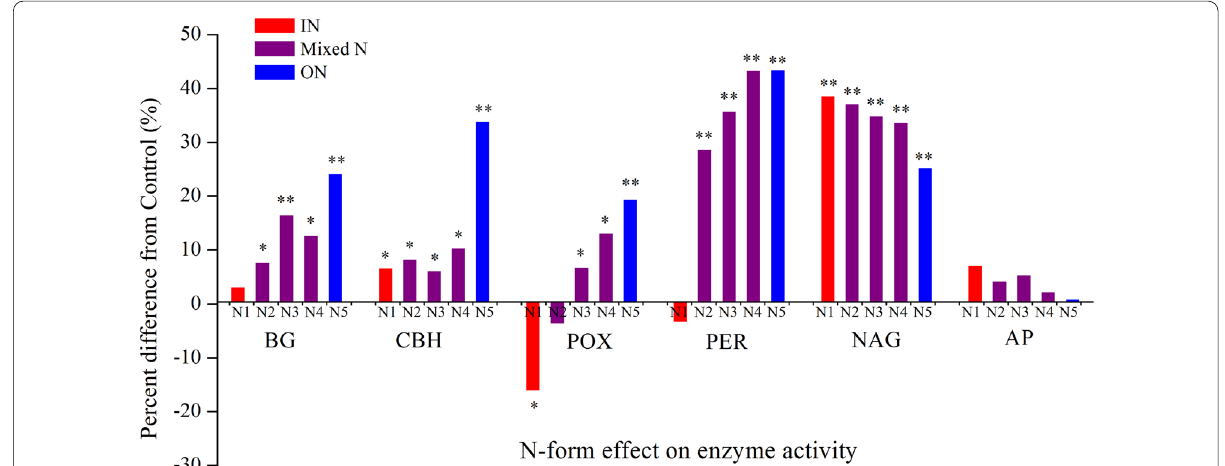
Fig. 1 Percentage difference in soil extracellular enzyme activities following different forms of N treatment (N trt ) compared to control treatment (CK) calculated as [( N trt CK)/CK 100%]. Asterisks (*) indicate significant differences for Tukey’s HSD test in multiple comparisons of different − × forms of N treatment from control (* P < 0.05; ** P < 0.01). IN (N1, IN:ON